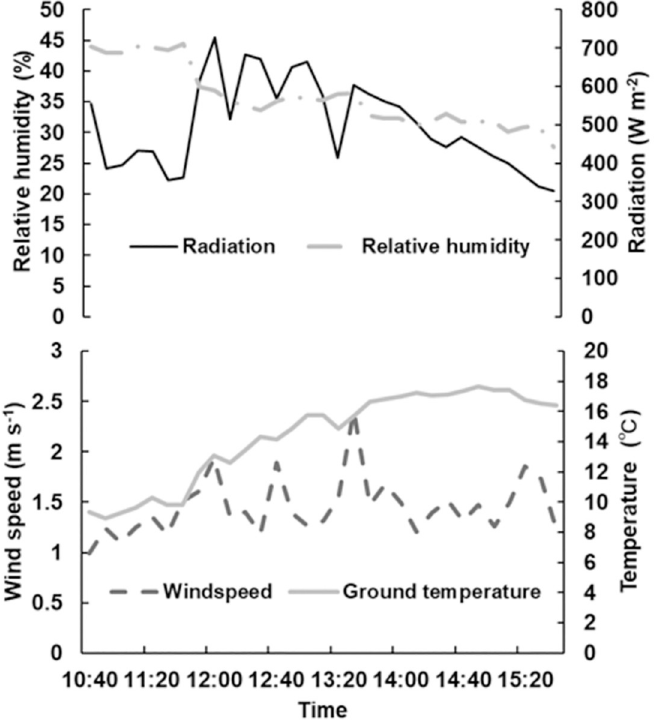
Fig 6. Environmental conditions at the roof of West 5 Building of Kyushu University on 19 January 2022. The top graph shows radiation and relative humidity, and the bottom graph shows wind speed and ground temperature.